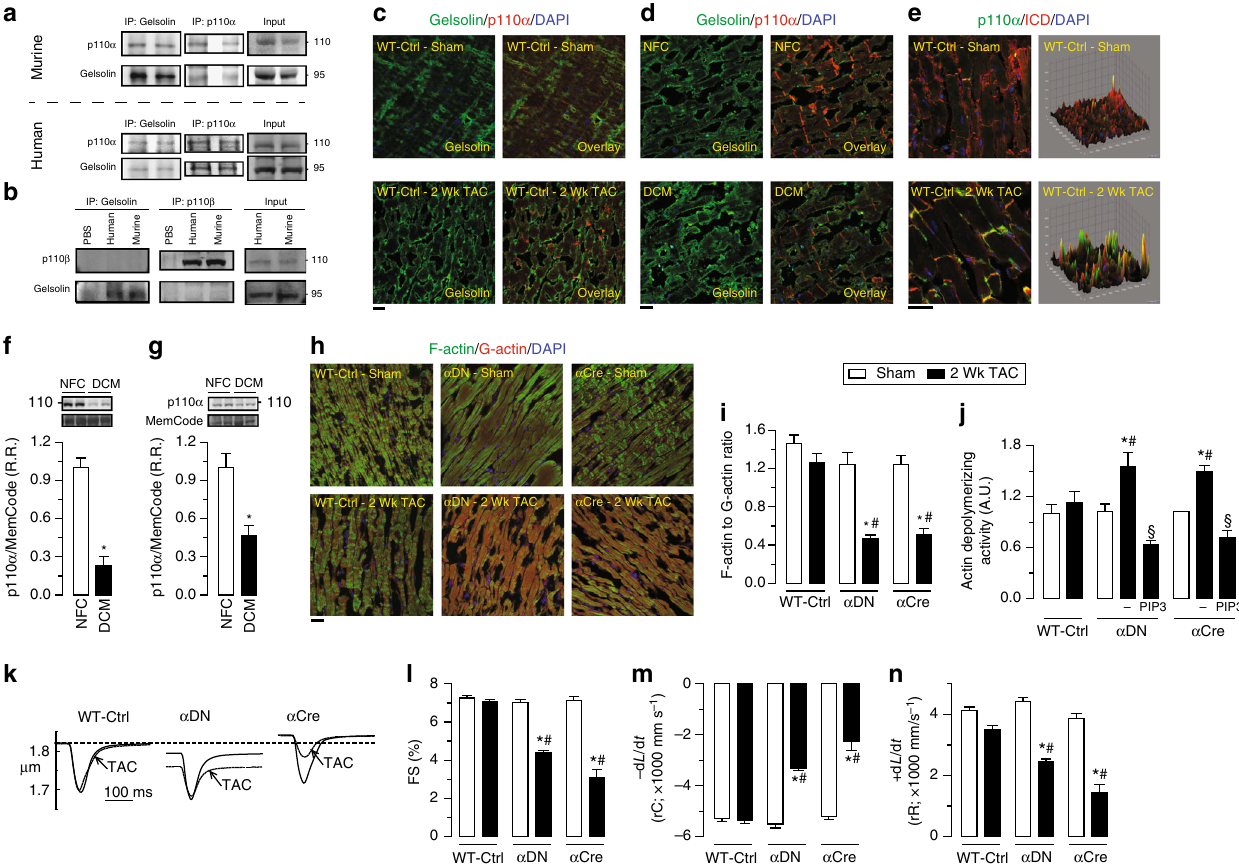
Fig. 5 p110 α , but not p110 β , interacts with gelsolin. a Co-immunoprecipitation and immunoblotting showing that p110 α and gelsolin interact in murine and human hearts. b Co-immunoprecipitation and immunoblotting showing no interaction between p110 β and gelsolin in murine and human hearts. c , d Representative IF staining images showing spatial colocalization between p110 α and gelsolin in murine ( c ) and human ( d ) hearts. e Representative IF staining images for p110 α and N-cadherin in murine hearts showing the localization of p110 α at the intercalated discs. Surface plots were plotted using Fiji ImageJ (NIH) show a graphical representation of intensity pro fi les of the IF images. f – g Western blot analyses showing decreased myocardial levels of p110 α in human ( f ) and canine ( g ) hearts with DCM compared with the NFC donor hearts. h – j Representative images of F- and G-actin staining ( h ), F- to G-actin ratio ( i ), and actin-depolymerizing activity derived from actin-depolymerization assay ( j ) showing a greater degree of actin depolymerization in p110 α transgenic mice in response to pressure overload-induced biomechanical stress. Addition of PIP3, in the presence of VO-OHpic, inhibited the actin- depolymerizing activity ( j ). k – n Single cardiomyocyte contractility measurements ( k ) showing decreased myo fi lament FS ( m ) and ±d L /d t ( l – n ) in LV cardiomyocytes isolated from 2 weeks of pressure-overloaded p110 α transgenic mice hearts. Data represent means ± s.e.m. * P < 0.05 compared with the respective sham/NFC groups, # P < 0.05 compared with WT-Ctrl — 2 week TAC group as determined by unpaired two-tailed Student ’ s t test ( f , g ) and one- way ANOVA analysis ( i , j , l – n ). Biological replicates: n = 4 ( a – j ) and n = 6 ( k – n ). Scale bars show 25 µ m ( c , d , e ,